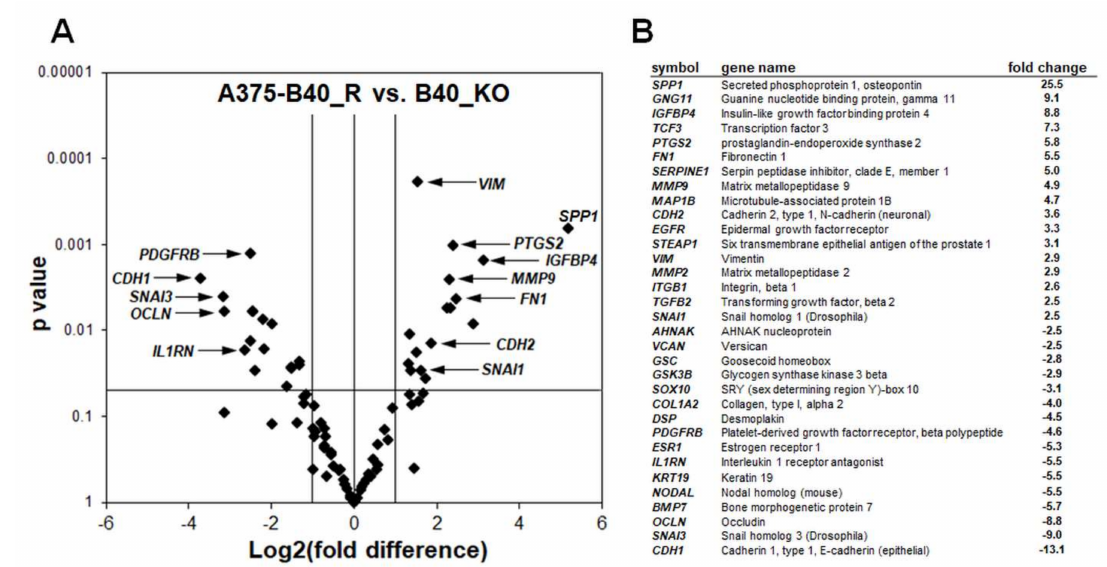
Figure 7. GLO1 rescue (A375- GLO1_ R) restores EMT-related gene expression in A375 malignant melanoma cells with genomic GLO1 deletion. ( A ) Volcano plot depicting di ff erential gene expression (B40_R versus B40_KO), as detected by the RT 2 Profiler TM PCR expression array technology (cut-o ff criteria: expression di ff erential > 2; p ≤ 0.05; n = 3). ( B ) Numerical expression changes [B40_R versus B40_KO ( p ≤ 0.05; n = 3)] revealing modulation of EMT-related genes as a function of GLO1 expression and